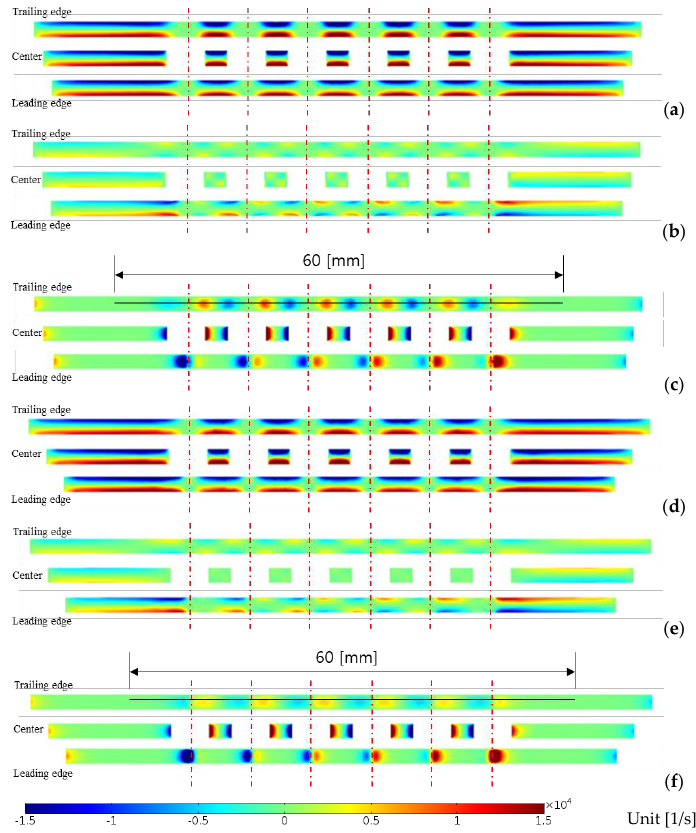
Figure 17. Vorticity components of cross flow: ( a ) 𝜔 𝑥 , ( b ) 𝜔 𝑦 , ( c ) 𝜔 𝑧 in Case 2; ( d ) 𝜔 𝑥 , ( e ) 𝜔 𝑦 , ( f ) 𝜔 𝑧 in Case 8.